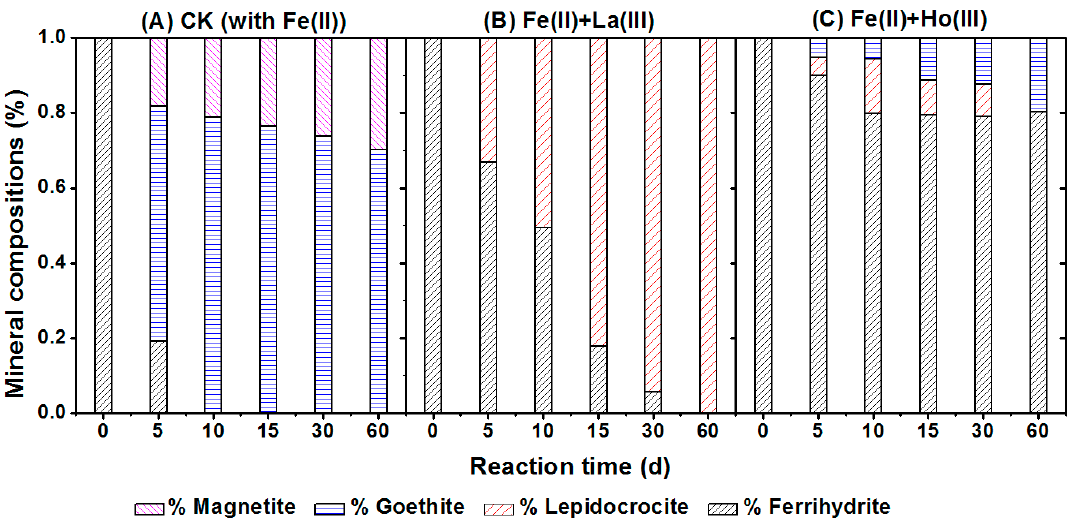
Figure 2. The compositions of iron (hydr)oxides of the transformed ferrihydrite: ( A ) Fe(II) aq induced without any Ln(III); ( B ) Fe(II) aq induced with the presence of La(III); and ( C ) Fe(II) aq induced with the presence of Ho(III).